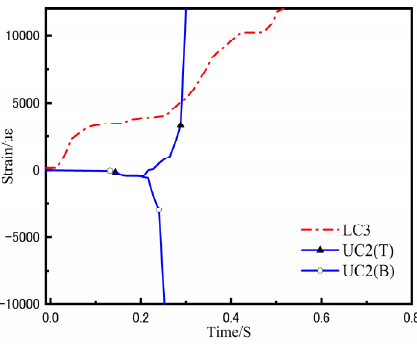
Figure 18. LC3, UC2 strain time history.